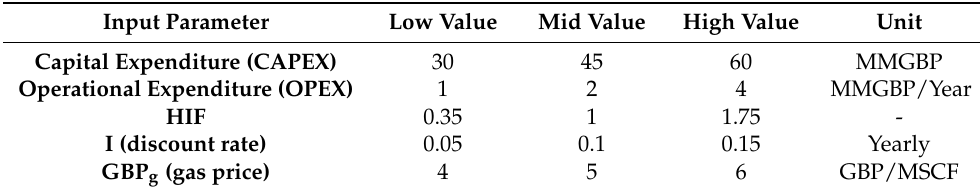
Table 1. The uncertainty range for the sensitivity